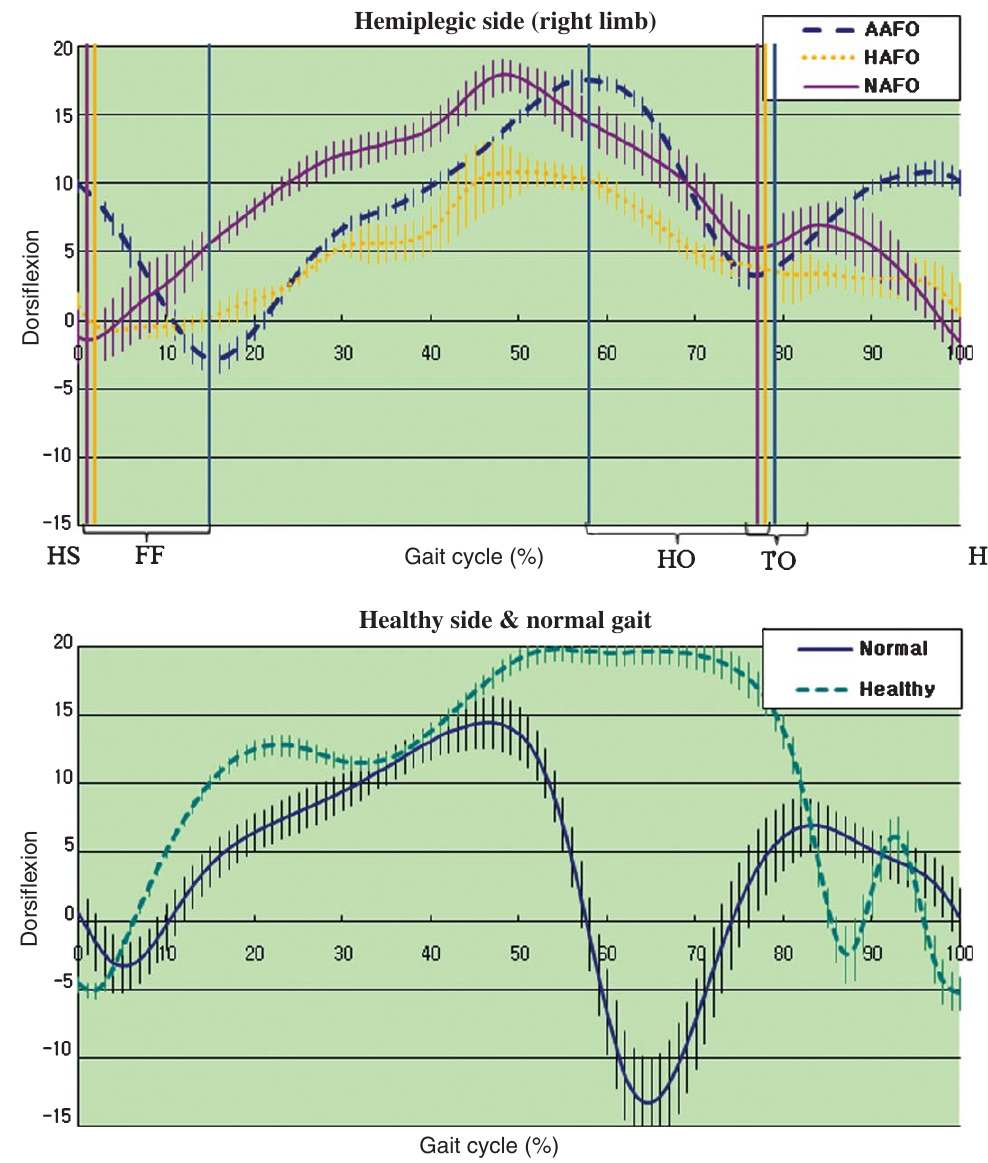
Fig. 9. Ankle joint angles during normal, NAFO, HAFO, and AAFO